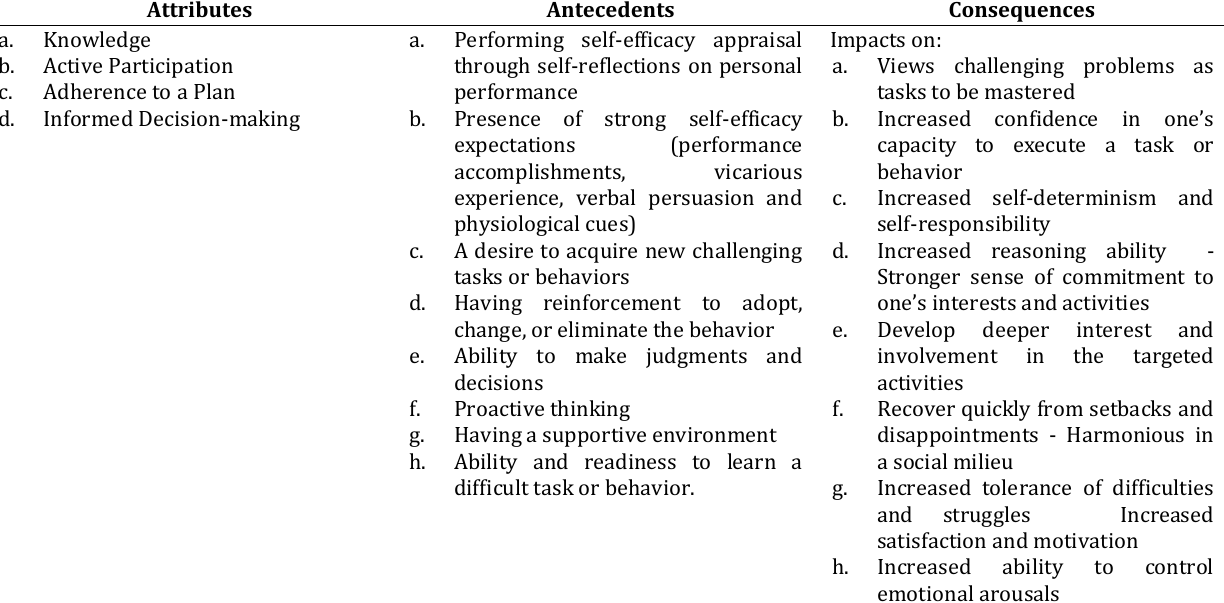
Table 1. The summary of the Concept Analysis of Self-Efficacy of Exercise in Older Adults with Diabetes: Attributes, Antecedents, and